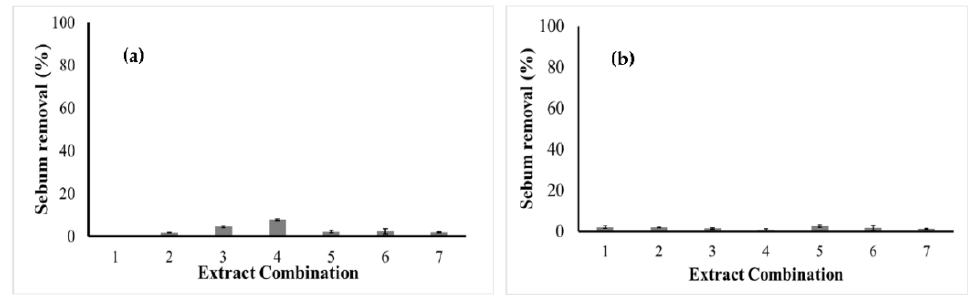
Figure 4. Cleaning potential of plant extracts at concentrations of ( a ) 4% and ( b ) 10%. Extract combinations: 1. C. quinoa ; 2. G. max ; 3. M. emarginata ; 4. C. quinoa + G. max ; 5. C. quinoa + M.